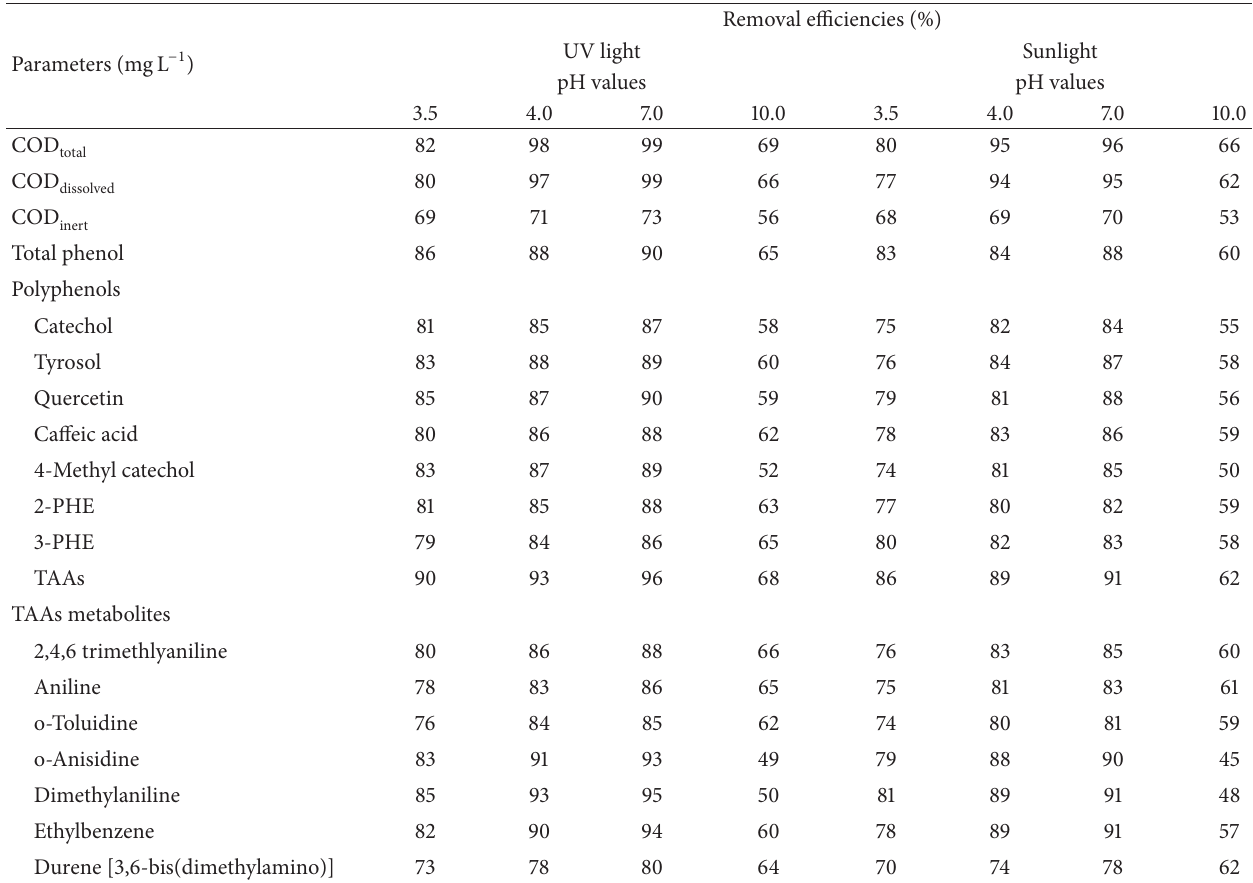
Table 5: Effect of increasing pH values on the removals of OMW during photocatalytic degradation, at 500 mgL − 1 C/TiO nanocomposites, under 300 W UV and 30 W sunlight irradiations, after 60min, at 25 ∘ C ( 𝑛 = 3, mean